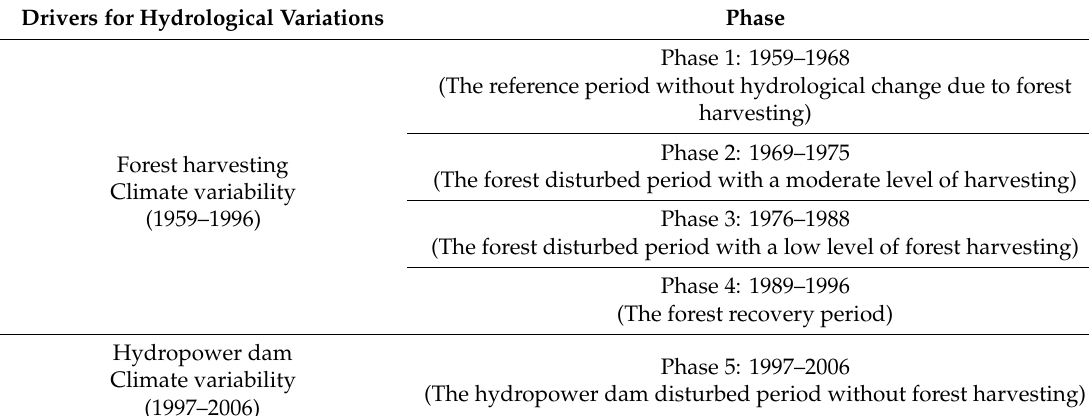
Table 1. The division of study periods for low flow regime responses